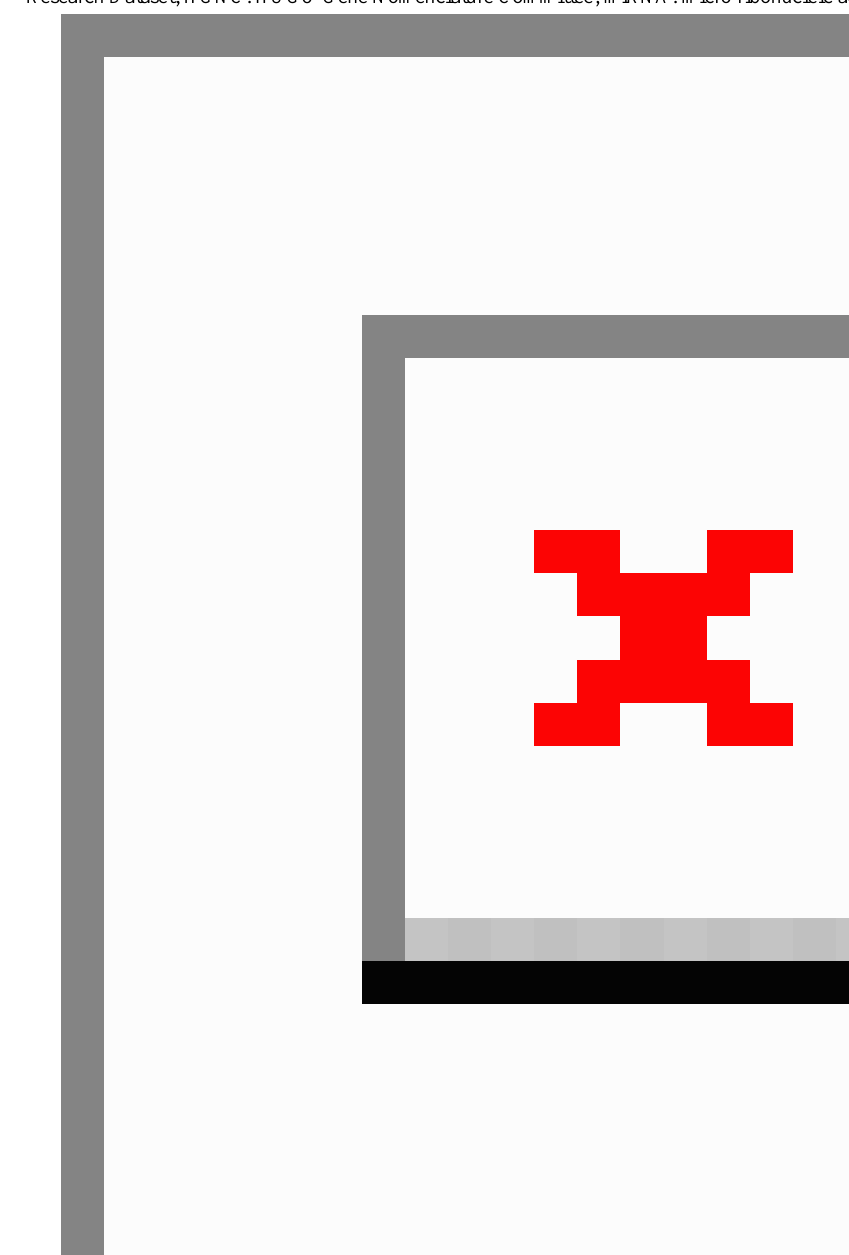
Figure 3. Flowchart of extracting disease-gene and disease-miRNA associations and determining their confidence levels. CORD-19: COVID-19